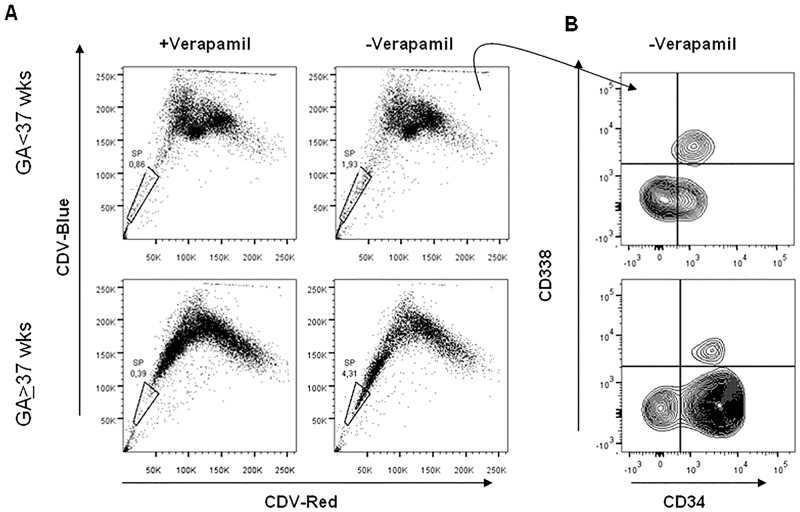
Side population (SP) analysis of human mononuclear cells obtained from pre-term and term cord blood.(A) DyeCycle Violet (DCV) blue vs red fluorescence is shown for all cells within the viable (7AAD-) CD45+dim/SCC low gate of the scatter plot. In these representative samples, 1.93% (for pre-term: GA<37 wks) and 4.31% (for term: GA≥37 wks) of the cells fall within the gated SP (-Verapamil) and are sensitive to Verapamil (+ Verapamil). (B) Expression of CD34 and CD338 (ABCG2 transporter) within SP population of preterm (n = 5) and term (n = 5) cord blood.